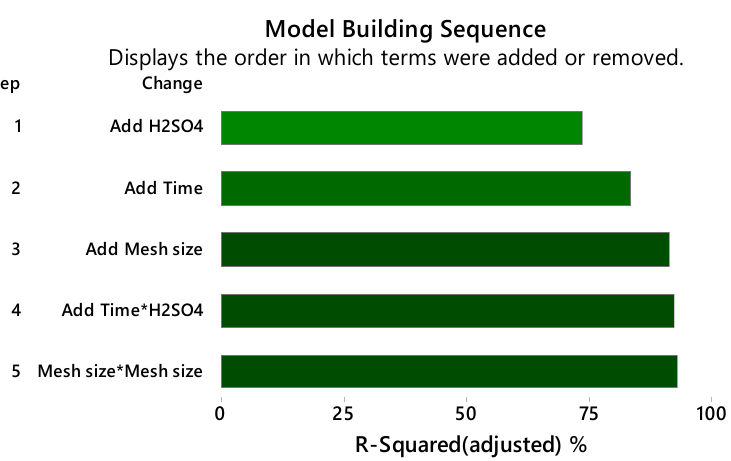
Figure 5. Curvature effect plot for Mn extraction.